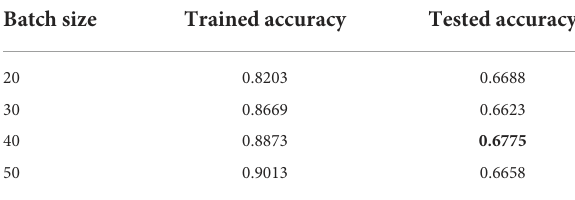
TABLE 10 Comparison of experimental results with different batch sizes.